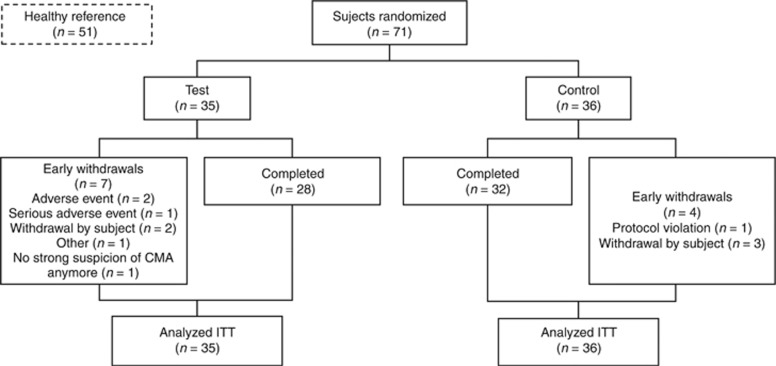
CONSORT diagram showing the flow of subjects in the randomized arms. ITT, intent to treat. Early withdrawal-related adverse events were constipation (n=1) and infantile colic (n=1), and related serious adverse event (n=1) was viral laryngitis. The events were reported as unlikely and not related to study formula.